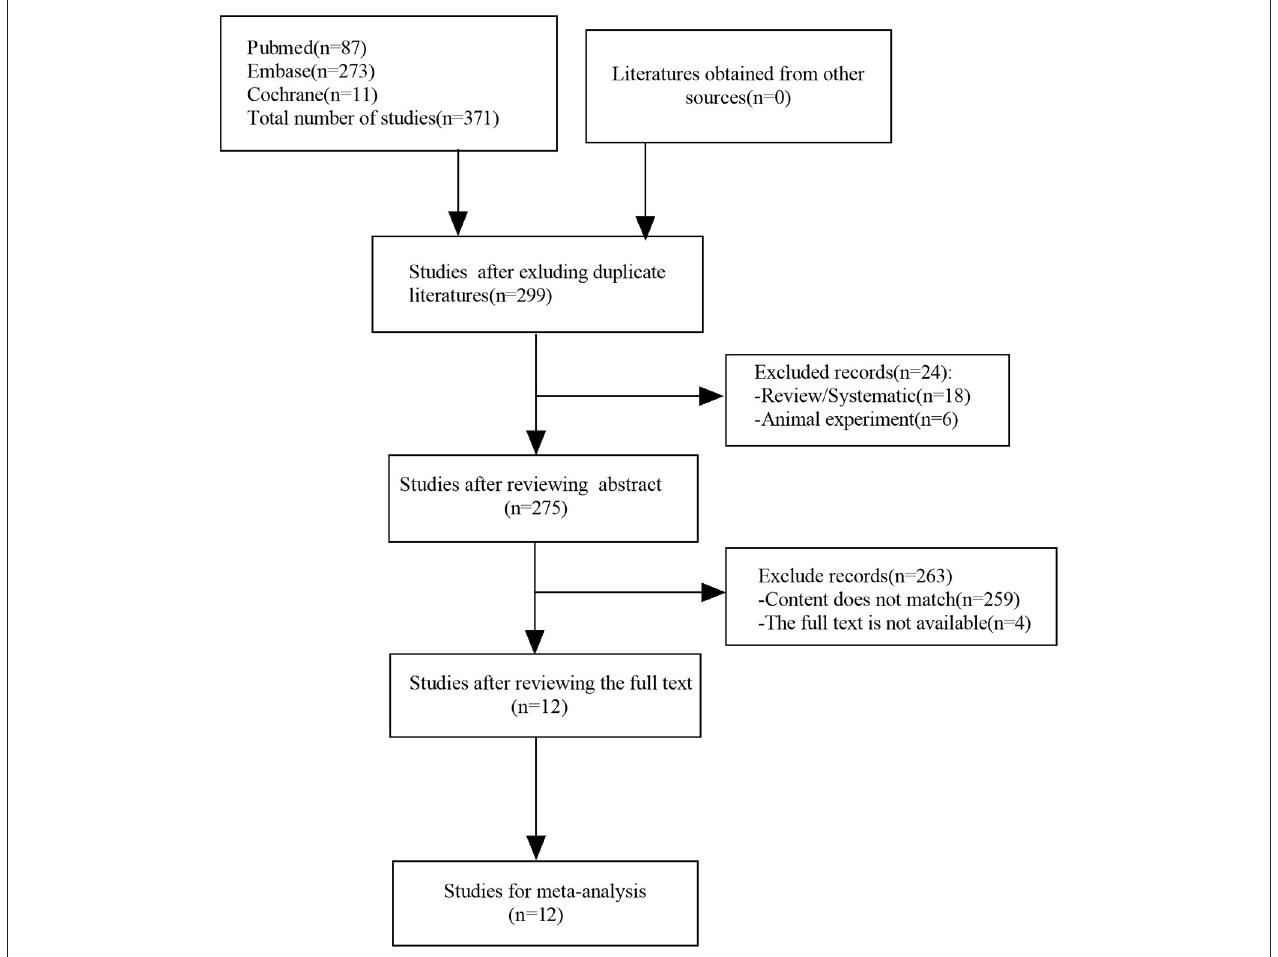
FIGURE 1 | PRISMA flow chart of the included